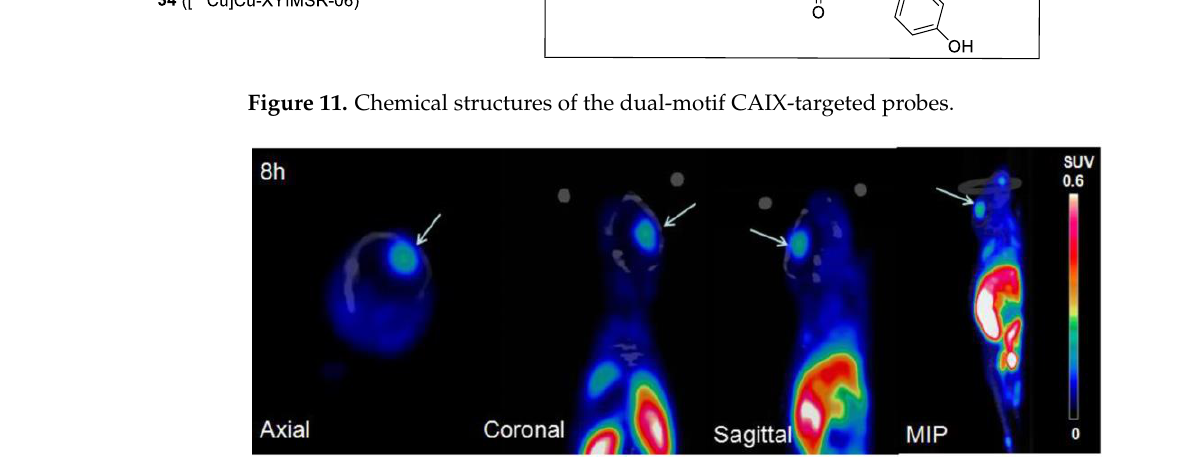
Figure 12. Micro-PET images of orthotopic U87MG xenografts of [ 64 Cu]Cu-XYIMSR-06 ( 34 ) at 8 h